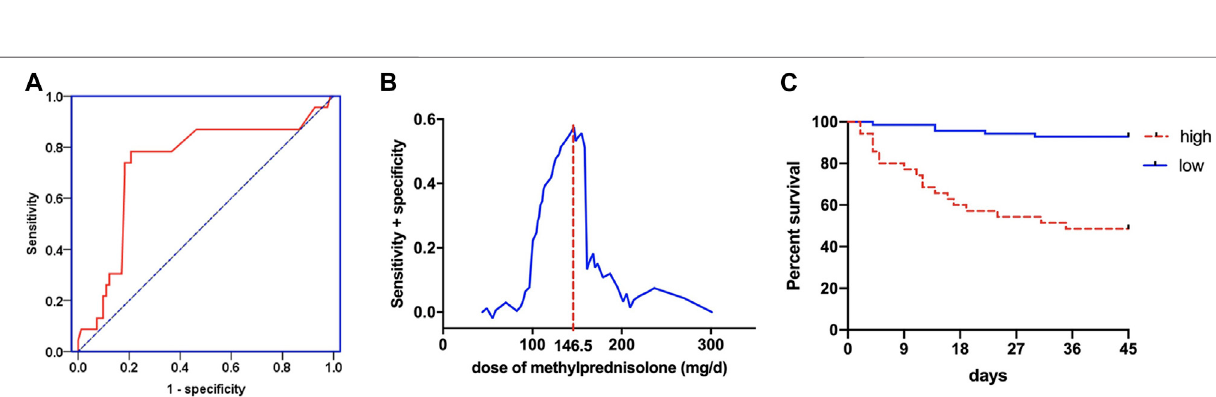
lymphocyte ratio (E) . APACHE II score at day 1, day 3, and day 7 (F) .